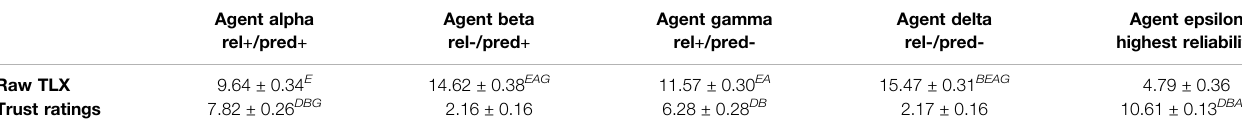
TABLE 2 | Metrics related to cognitive load and trust ratings. Superscript letters next to the results indicate which agents yielded signi fi cantly worse scores ( p < 0 .